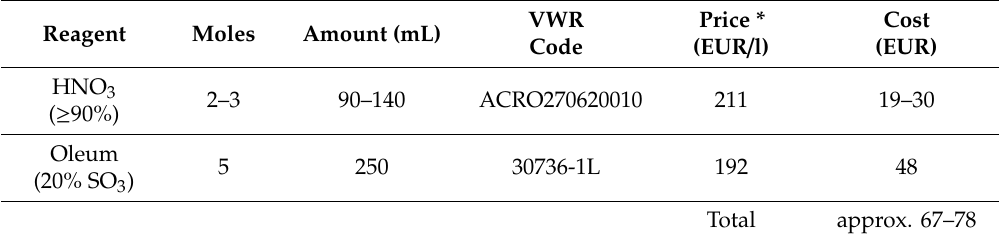
Table 3. Approximate cost of the reagents needed for the conversion of 1 mole 2,4-DNT to TNT using the conventional batch method.